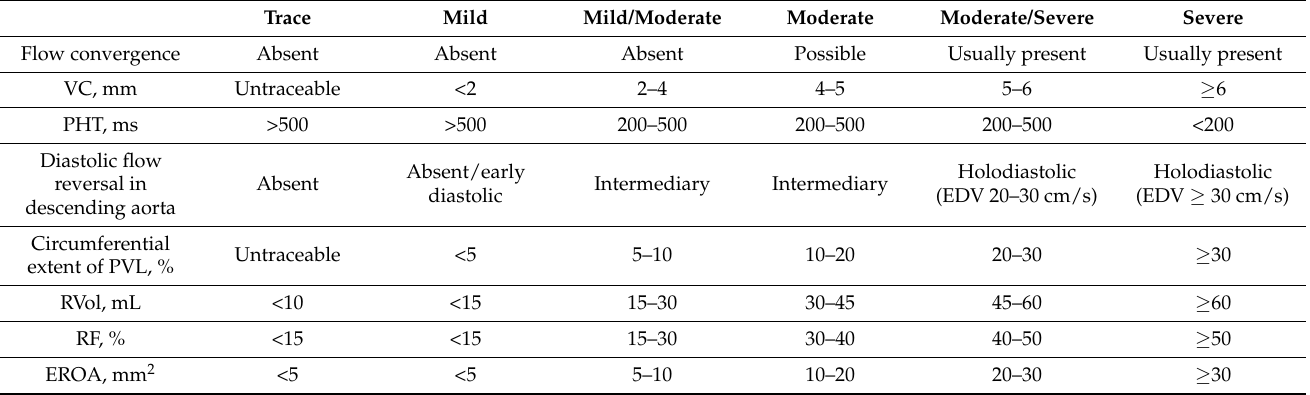
Table 1. Selected echocardiography parameters useful for aortic PVL grading [1–4].